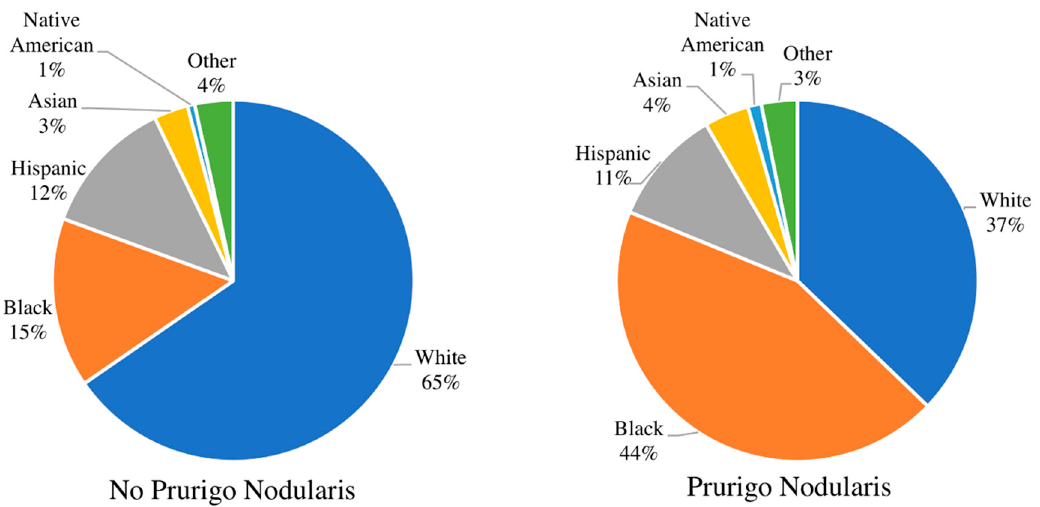
Figure 1. Comparison of racial distribution. The racial distribution of patients with no prurigo nodularis ( left ) compared to patients with prurigo nodularis ( right ). The population of prurigo nodularis patients is disproportionately black compared to patients with no prurigo nodularis.